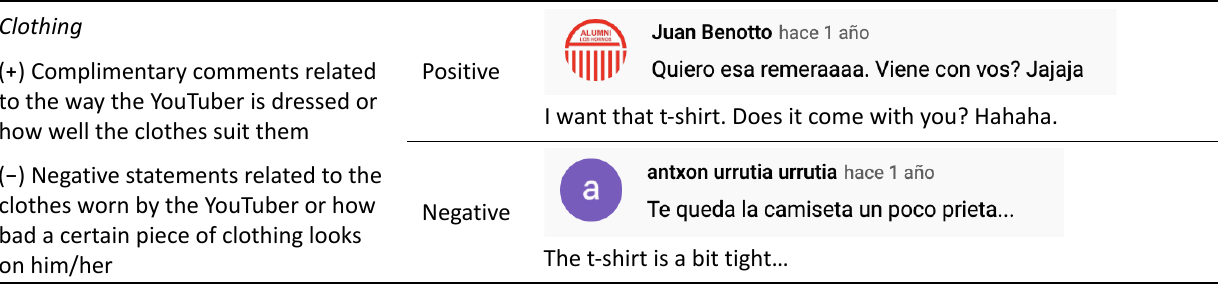
Table 4. (Cont.) Personal comments and valences identified in the science popularisation videos disseminated through YouTube (2019–2020).